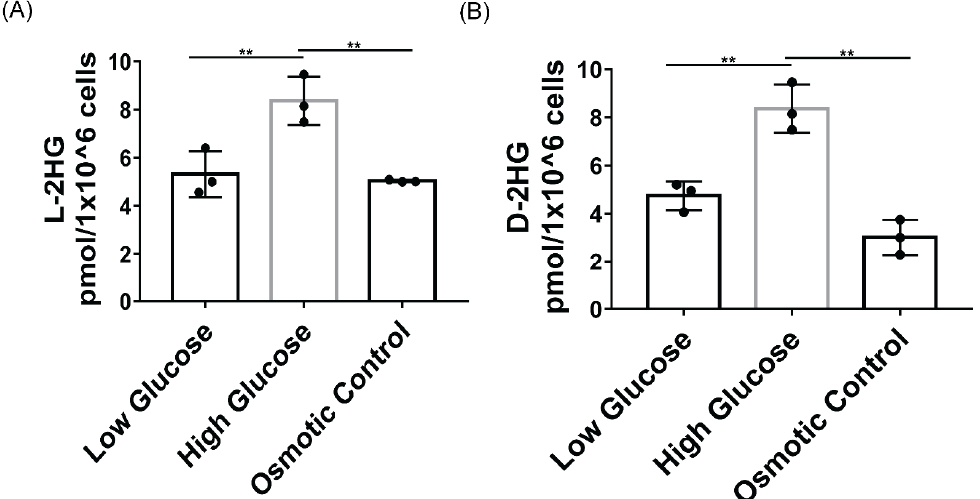
Figure 3. HK-2 production of D and L-2HG in high glucose media. ( A ) L-2HG and ( B ) 2-HG levels from HK-2 cells cultured in 5 mM glucose (low glucose), 25 mM glucose (high glucose), 5 mM glucose with 20 mM mannitol (osmotic control). One- way ANOVA with Tukey’s post hoc correction, ** = p -value ≤ 0.01.